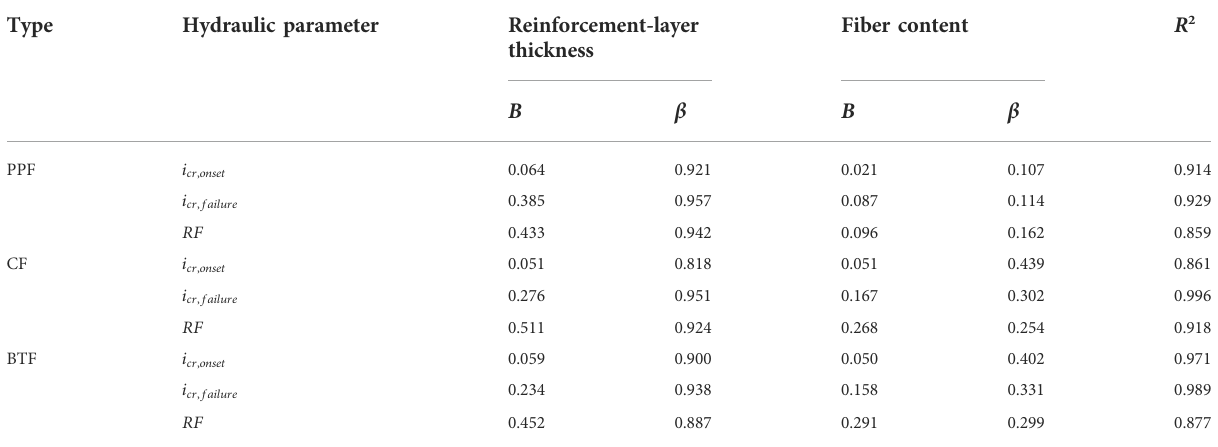
TABLE 5 Summary of linear regression